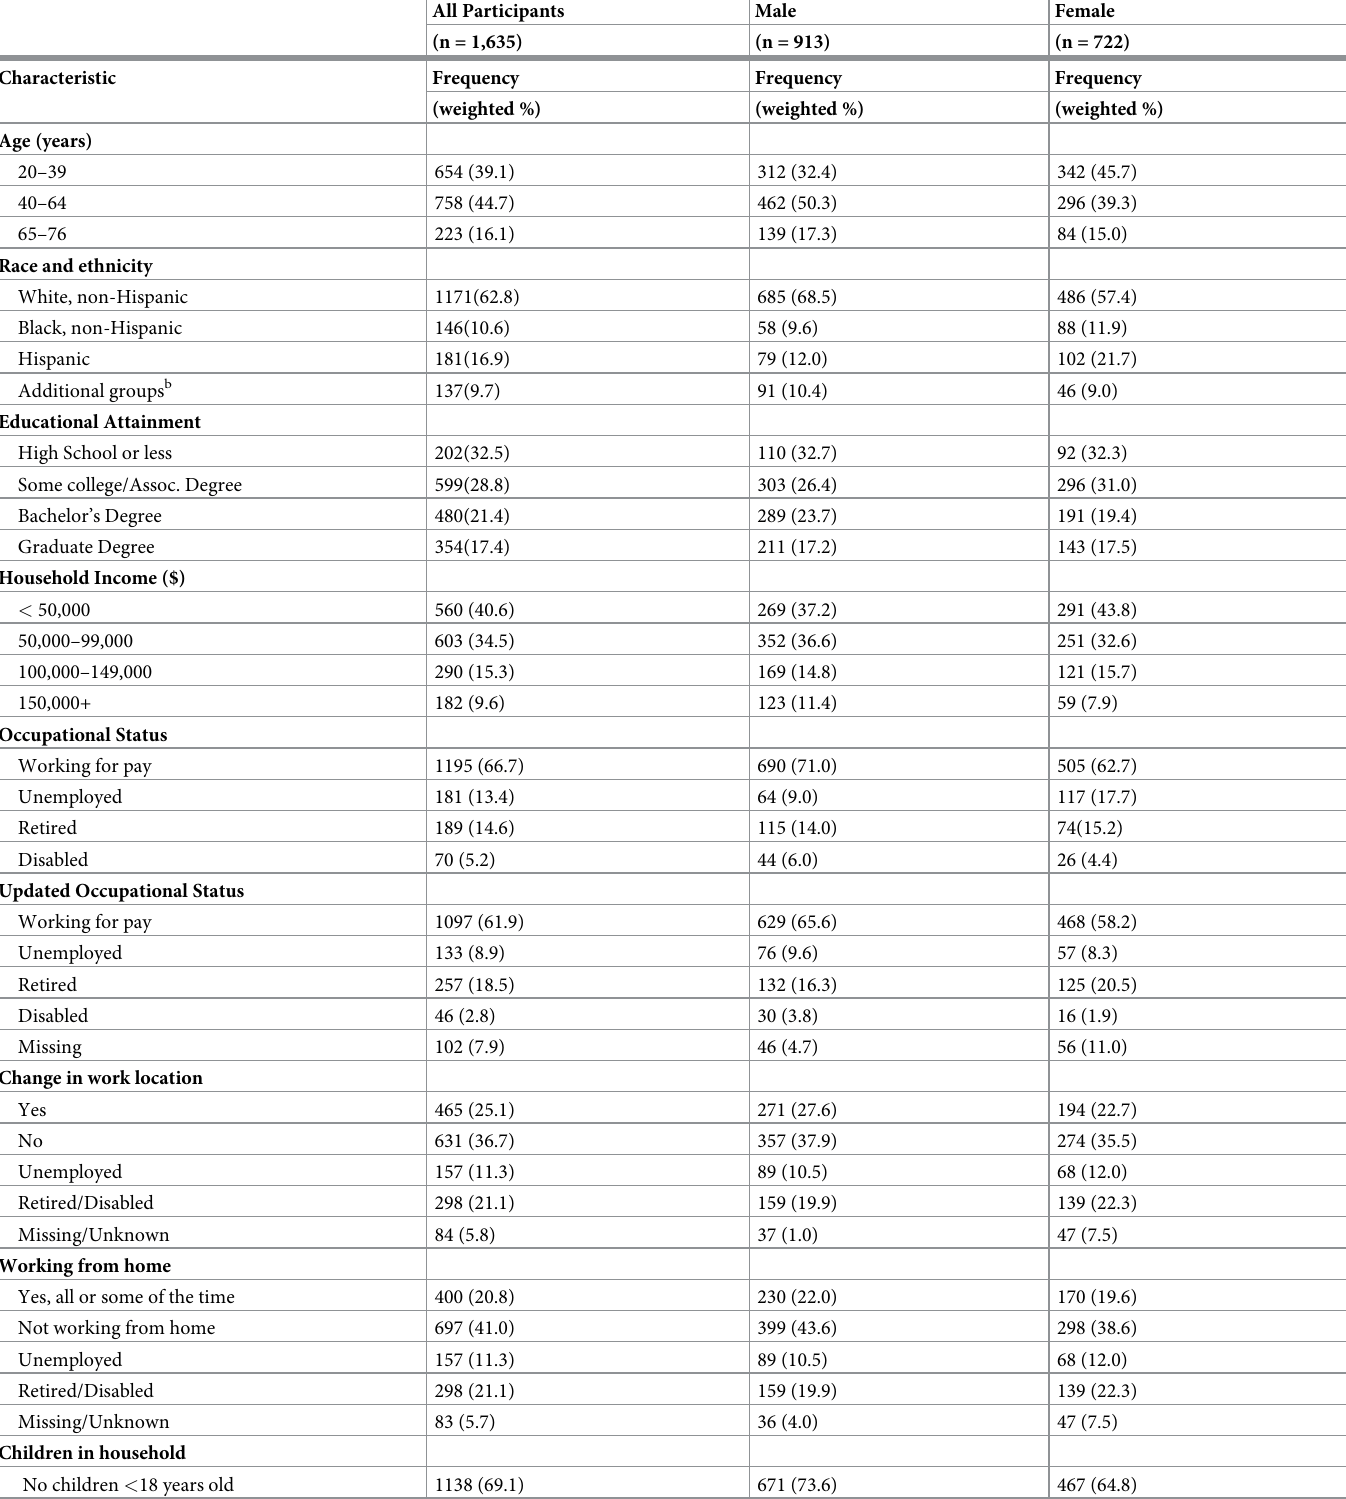
Table 1. Descriptive characteristics of the analytic sample a